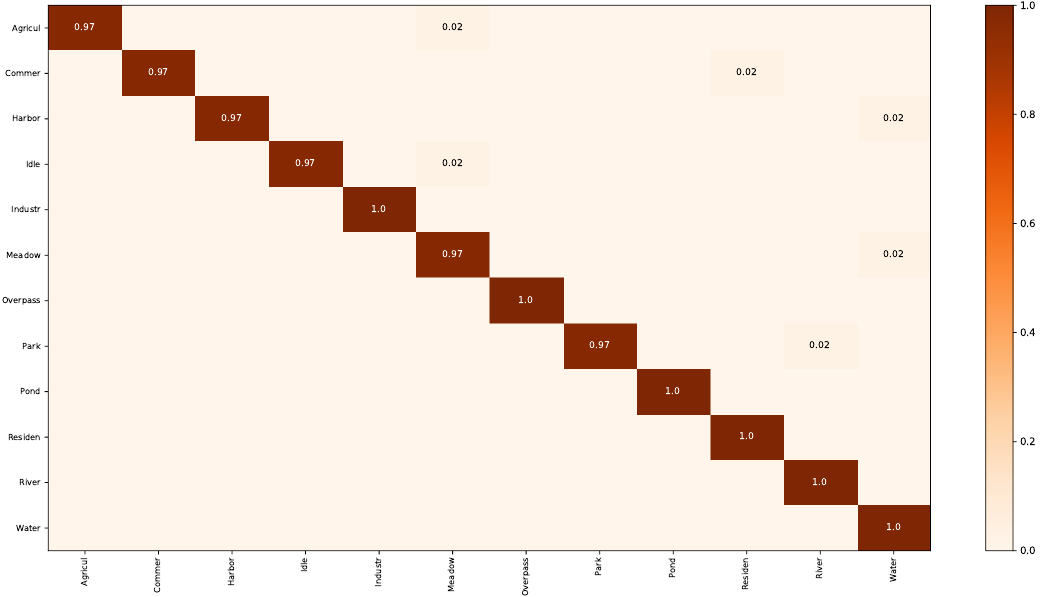
Figure 12. CM of the SIRI-WHU dataset for a 80% training ratio (only displays results greater than 0.01). Table 3. Performance comparison on the SIRI-WHU dataset (—-: not reported).